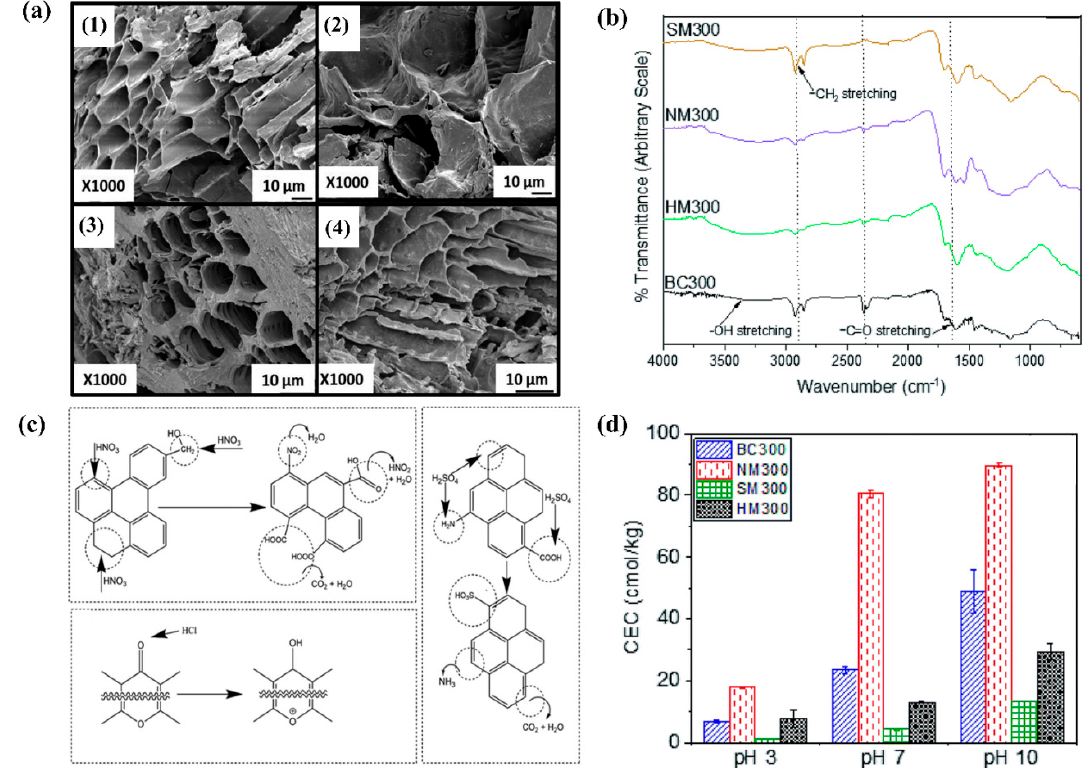
Figure 3. ( a ) SEM images of raw BCs, ( b ) FTIR spectra of modified BCs pyrolyzed under 300 °C, ( c ) proposed key reaction mechanisms involved in nitric, sulfuric, and hydrochloric modification, ( d ) CEC variation under different pH values modified 300BCs [74] (Reproduced with permission from Peiris et al., RSC Advances, published by the Royal Society of Chemistry, 2019).